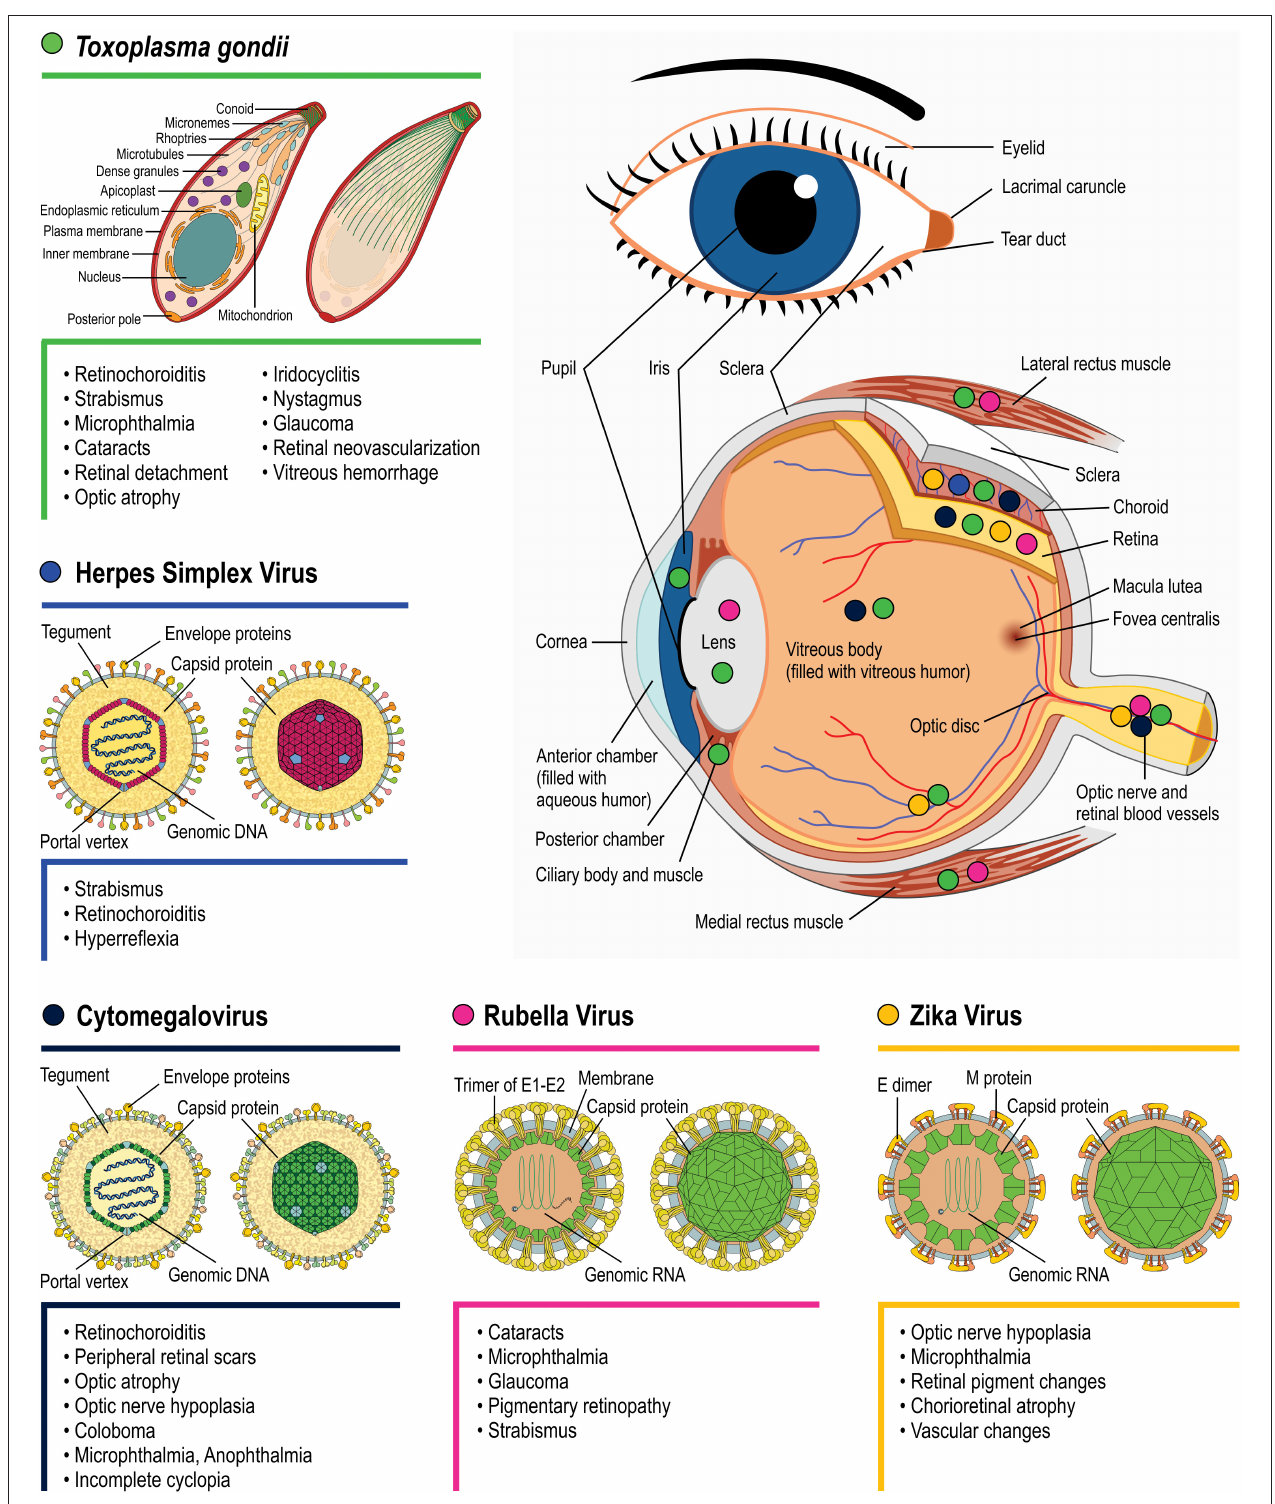
FIGURE 3 | Main eye structures affected by each TORCH agent during development (indicated by colored circles). Clinical consequences regarding congenital T. gondii (green symbols), Herpes simplex virus (blue), Rubella virus (magenta), Zika Virus (orange), and Cytomegalovirus (navy blue) infection are listed besides each pathogen’s name. Viral structure representations were based on Hulo et al. (2011).